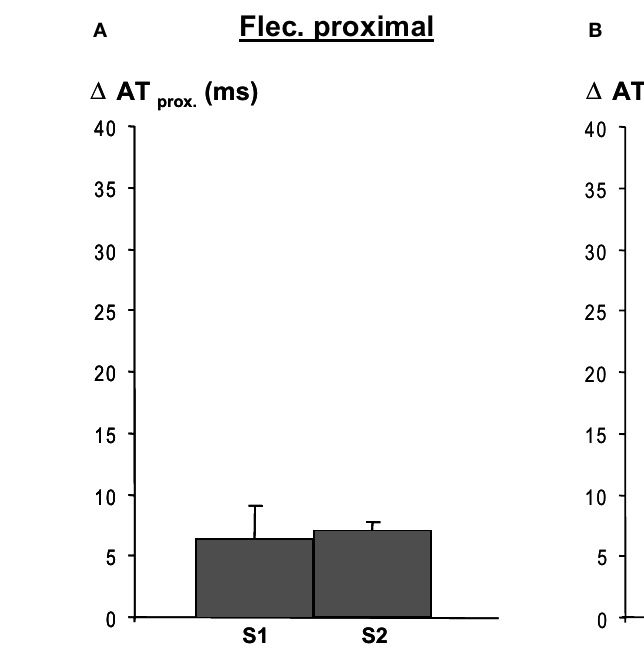
Figure 4 | regional flecainide (flec) infusion causes activation delay in the respective regions following a basic beat (S1) and a premature beat (S2), and both during proximal (panel A)and distal (panel B) application of flecainide. After S2 conduction delays are more pronounced when flecainide is infused in the